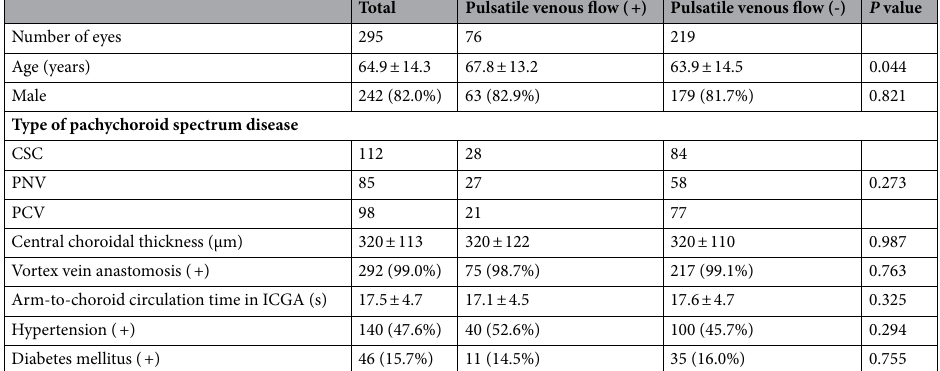
Table 1. Demographic and clinical characteristics of patients with pachychoroid spectrum diseases. CSC central serous chorioretinopathy; PNV pachychoroid neovasculopathy without polypoidal lesions; PCV polypoidal choroidal vasculopathy (pachychoroid neovasculopathy with polypoidal lesions); ICGA indocyanine green